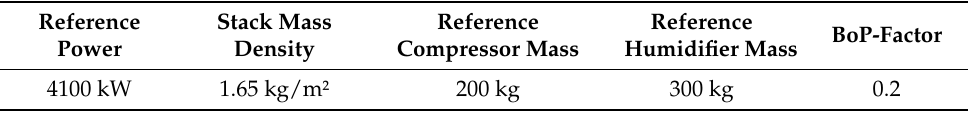
Table 4. Reference data for the fuel-cell system calculation [47].